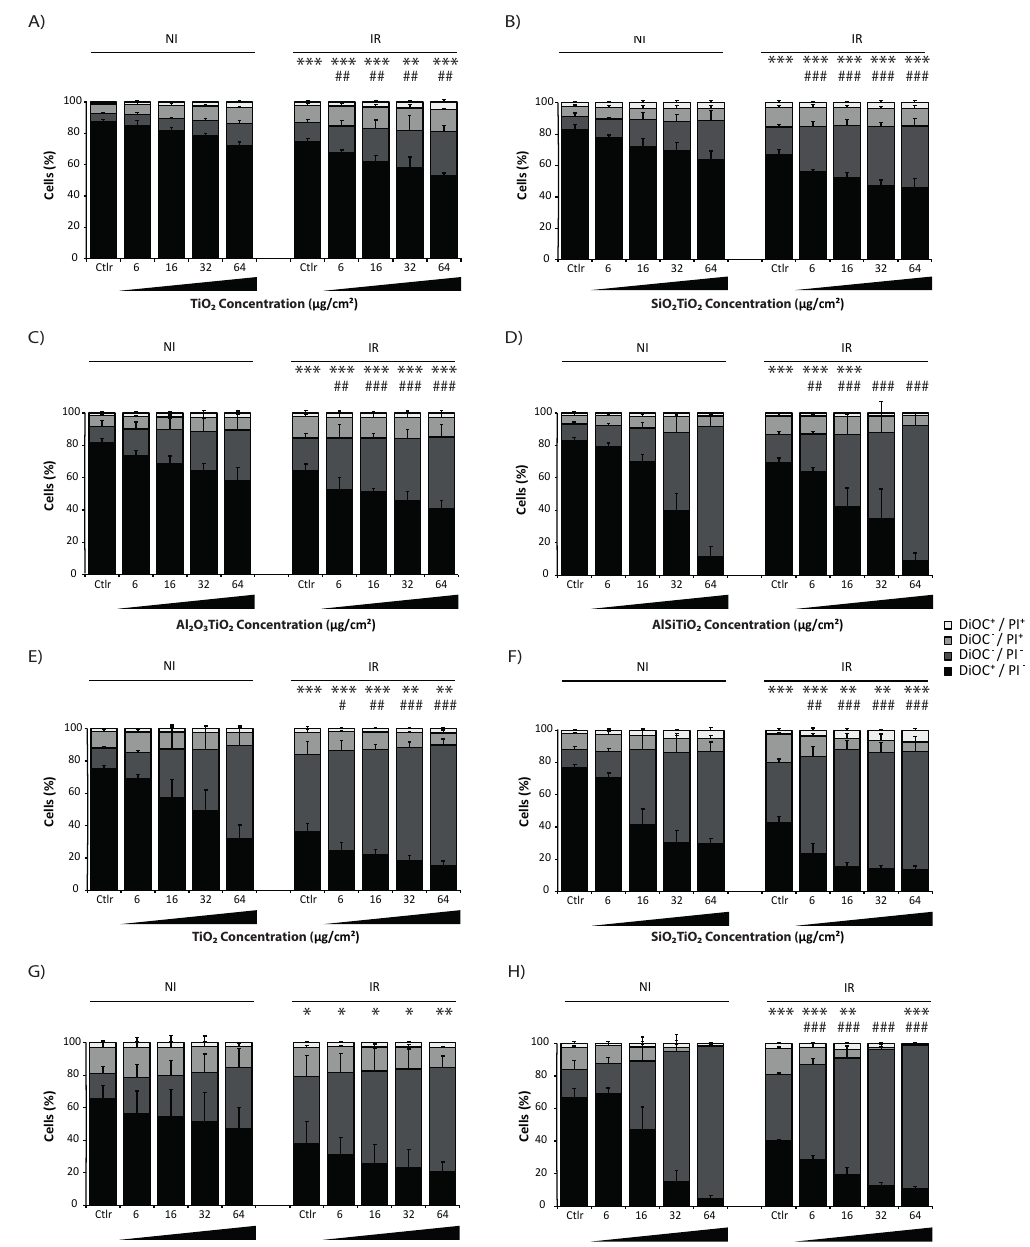
Figure 2. Cell death assay performed 72 h and 7 days after TiO 2 treatment combined or not with 4 Gy irradiation. Human bronchial epithelial 16HBE14o- cells are maintained in control conditions (Ctlr) or treated with 6, 16, 32 or 64 µ g / cm 2 of ( A , E ) titanium dioxide (TiO 2 ), ( B , F ) Silica coated titanium dioxide (SiO 2 TiO 2 ), ( C , G ) Aluminum coated titanium dioxide (Al 2 O 3 TiO 2 ) or ( D , H ) double silica and aluminum coated titanium dioxide (AlSiTiO2), and irradiated or not. Cells are maintained in culture for 72 h ( A – D ) or 7 days ( E – H ) after treatment and then co-stained for the cytofluorometric detection of cell death with DiOC6(3) and propidium iodide. Representative dot plots and quantitative data are reported (means ± S.D. n = 3, except for A) n = 2). * p < 0.05, ** p < 0.01, *** p < 0.001 (Student’s t -test), as compared with cells maintained in same conditions but non-irradiated. # p < 0.05, ## p < 0.01 and ### p < 0.001 (Student’s t -test), as compared with IR cells maintained in Ctlr